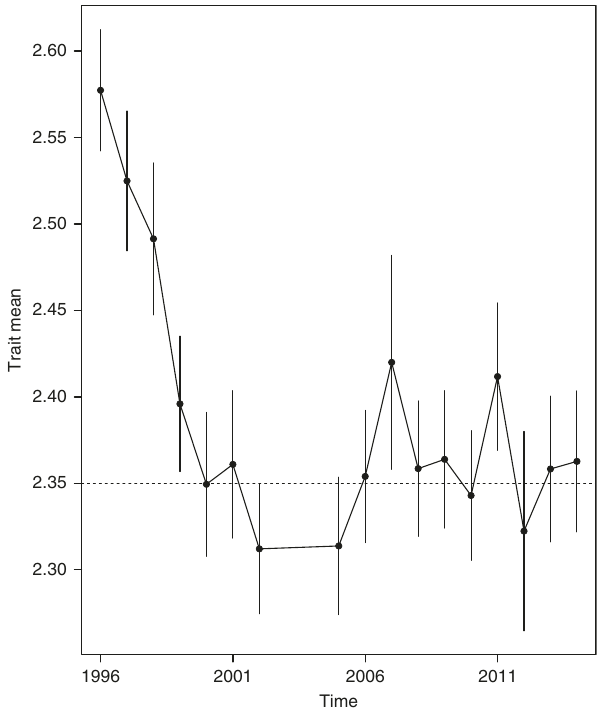
Fig. 2 Regression between uncorrected mean annual estimates of Log body mass (from Sætre et al. 1 ) and corrected mean annual estimates of log body mass (the values predicted by the fi rst ANCOVA model, where we regressed capture date (days away from the center of the breeding season (July 1st)) on log body mass (the dependent variable), having year a factor). The data show a strong concordance between both estimates ( R 2 = 0.92; P = 8.29e −